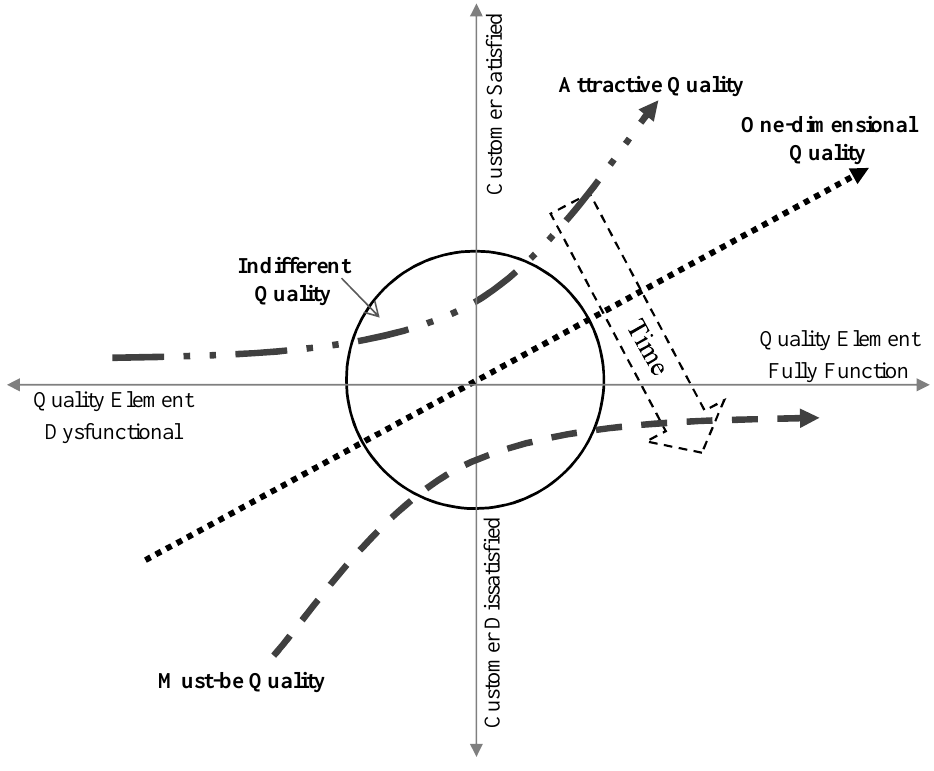
Figure 1 – The analytical Kano model (Lee et al.,